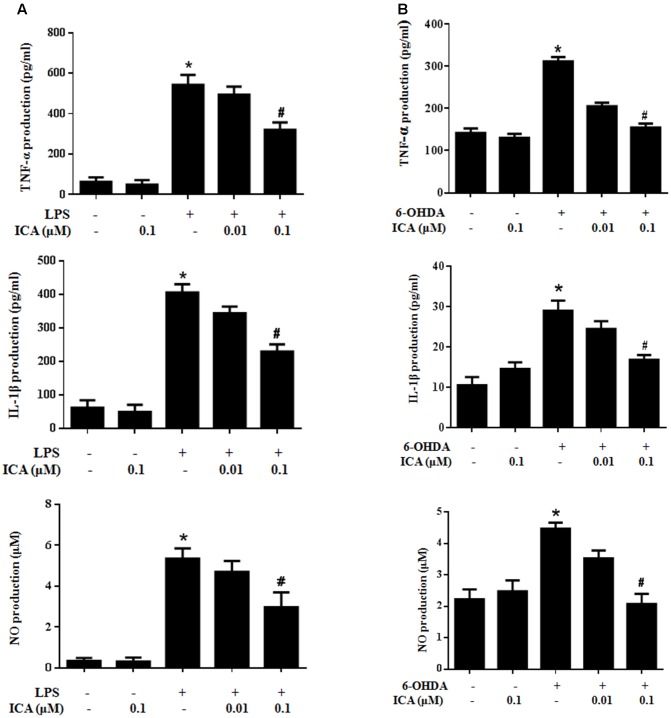
Icariin inhibited LPS-/6-OHDA-induced release of pro-inflammatory factors in vitro. Primary midbrain neuron-glia cultures were treated with ICA (0.01 and 0.1 μM) for 30 min followed by LPS (A) or 6-OHDA (B) treatment. Twenty-four h later, the release of TNF-α, IL-1β, and NO in the culture medium was detected by ELISA and Griess regent, respectively. Results were the mean ± SEM from three independent experiments performed in triplicate. ∗p < 0.05 compared with the control cultures; #p < 0.05 compared with LPS-/6-OHDA treated cultures.